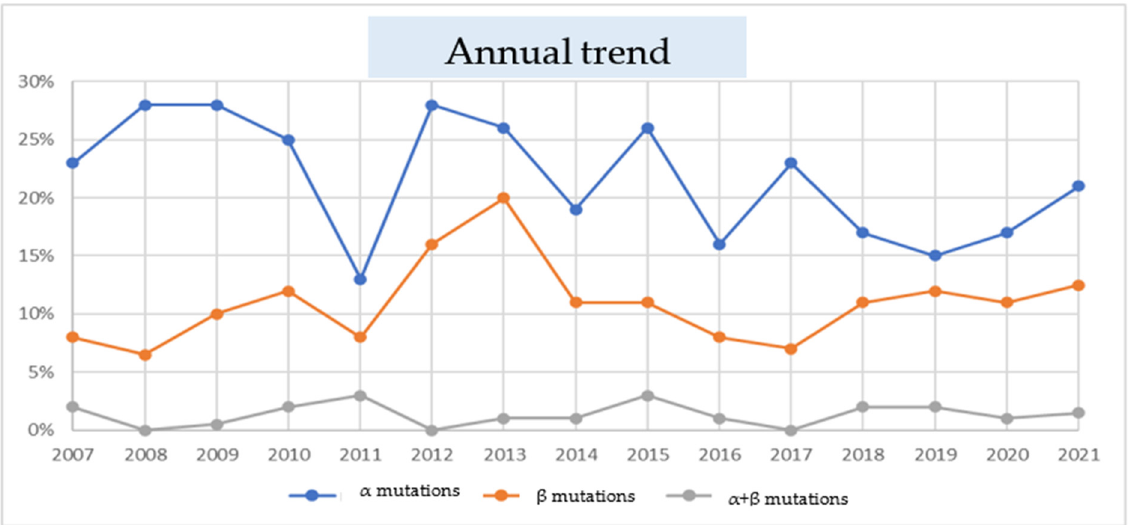
Figure 3. Annual trend of the examined mutations. Table 2. Frequencies of the mutations in the groups A, B and C.